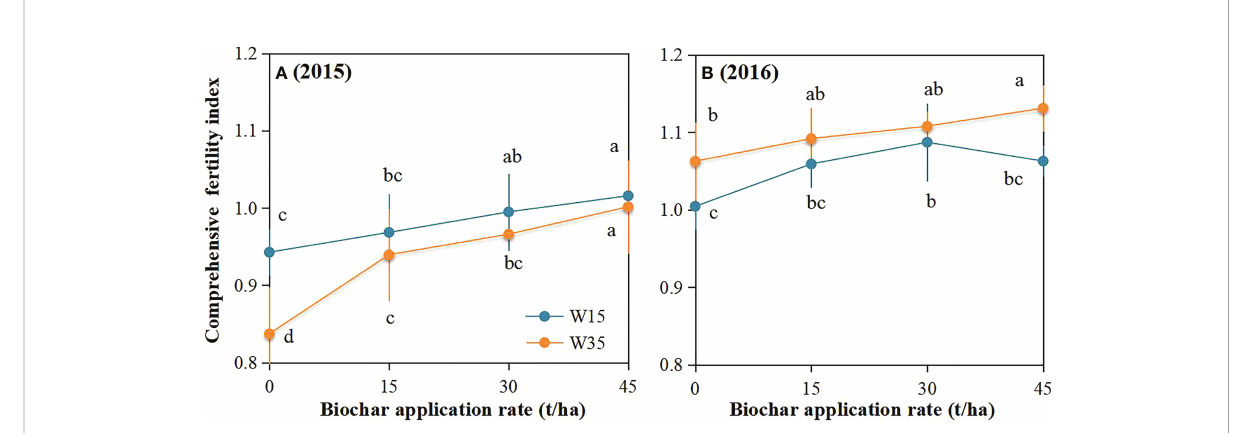
FIGURE 6 Comprehensive fertility index (CFI) for these fi ve variables in the top 15-cm soil layer during maize physiological maturity stage at biochar application rates (0 (B0), 15 (B15), 30 (B30), and 45 (B45) t ha -1 ) applied in irrigation water lower limits at soil matric potential -15 (W15) and -35 kPa (W35) for 2015 (A) and 2016 (B) . Different lowercase represents signi fi cant difference at P<0.05 between treatments.